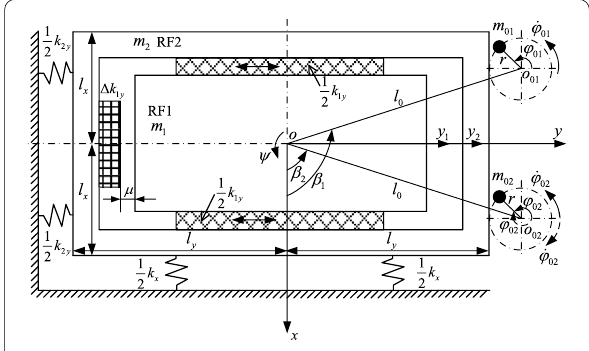
Figure 1 Dynamical model of a nonlinear vibrating mechanical system with two RFs driven by two identical